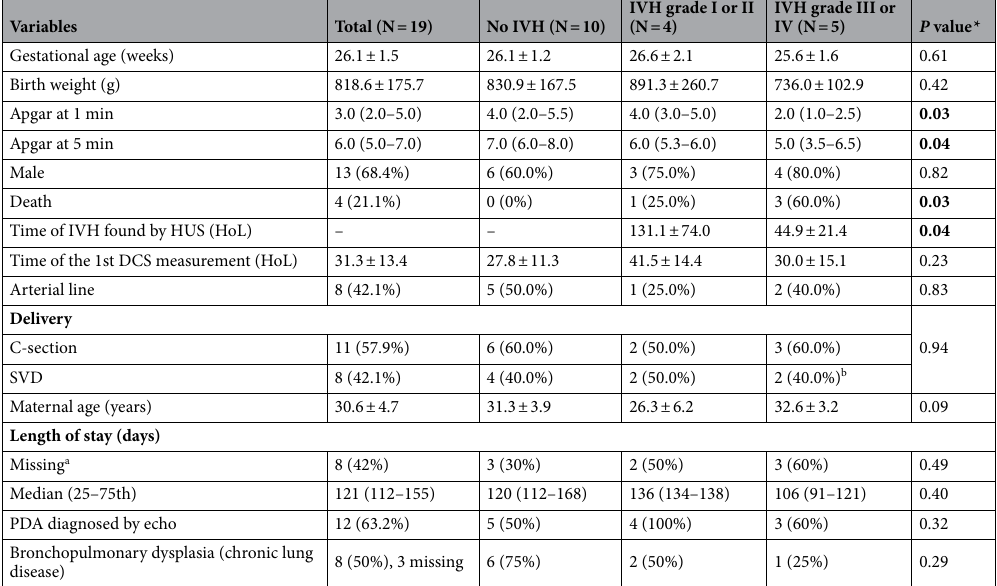
Table 1. Demographics and clinical characteristics among N = 19 infants by IVH status. Significant values are in bold. *Linear regression was used for continuous variables that passed the normality test (otherwise Wilcoxon/Kruskal–Wallis Rank Sums test was used) and Fisher’s Exact Test was used for categorical variables; a Missing includes the total days less than 30 (due to early death or a transfer) identified as outliers; b One case of vaginal-breech delivery. HUS Head ultrasound, HoL Hours of Life, SVD Spontaneous Vaginal Delivery. Data are presented as N (Column %) for categorical variables, except when presented as mean ± SD and when presented as median